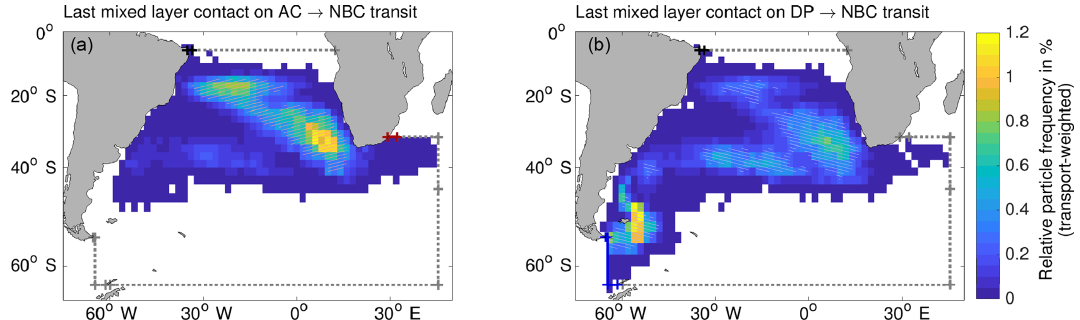
Figure 9. Horizontal distribution of the position of the last mixed layer contact for particles on the transit between (a) AC or (b) DP and NBC inferred from all 10 REF experiments. Relative transport-weighted particle frequency per 2 ◦ × 2 ◦ bin in percent (referring to the total number of particles that enter the mixed layer at least once during their transit; color shading); hatching highlights the most likely areas for the last mixed layer contact, encompassing 75% of the transport associated with the respective set of particles entering the mixed layer.